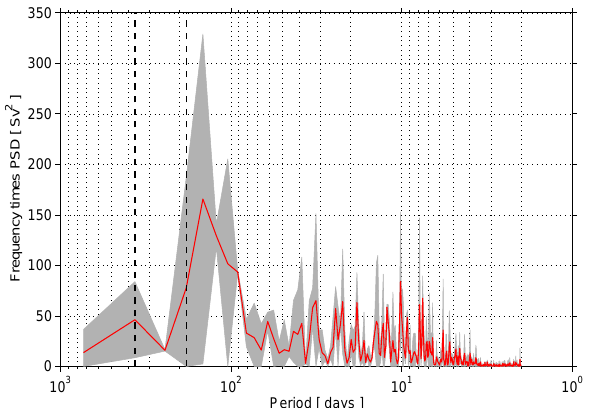
Figure 8. Variance-preserving spectrum of the DWBC volume transport using the continuous record that begins in July 2011. Spec- trum determined using Welch’s averaged periodogram method and a 2-year window allowing 1 year of overlap. Gray shading indicates the 95% confidence limits. Vertical black dashed lines indicate the annual and semi-annual